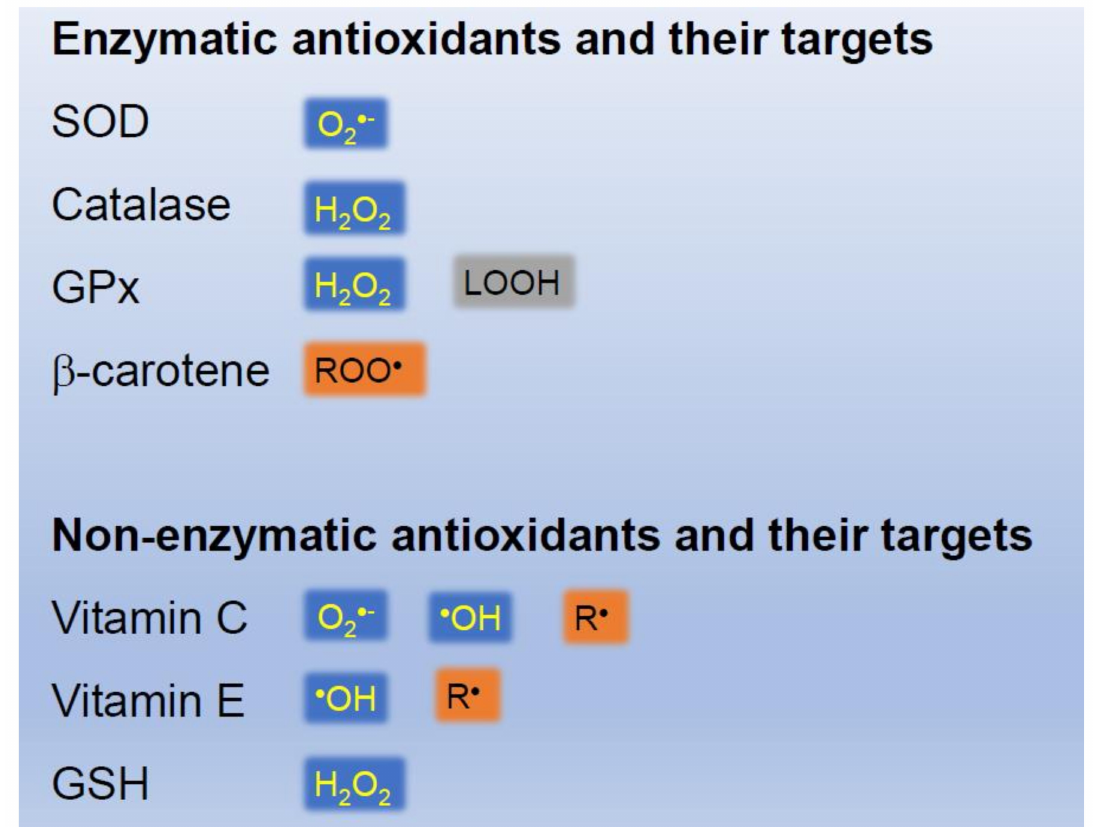
Figure 5. Examples of enzymatic and non-enzymatic